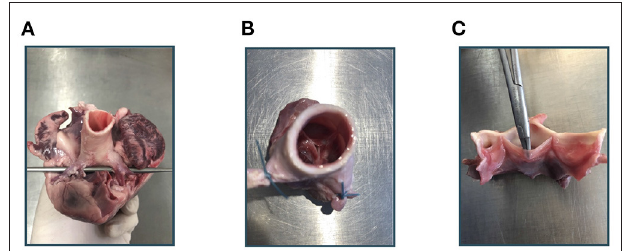
FIGURE 1 | Experimental workflow. At first, the aortic root is extracted from the porcine heart (A) . After clamping the coronary arteries (B) , an ultrasound image of the aortic root can be acquired. Then, the root is cut vertically and the leaflets can be extracted (C)